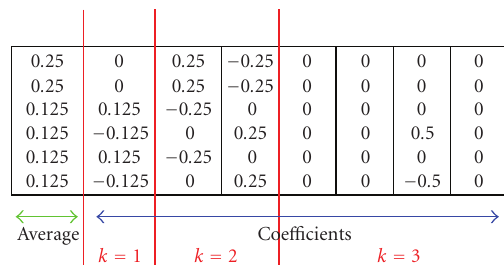
Figure 7: X after coe ffi cient selection.